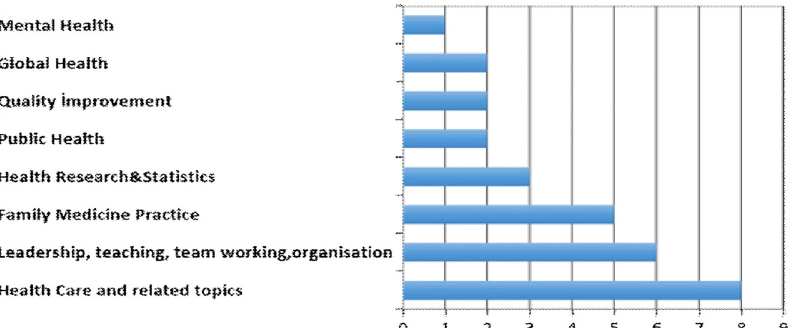
Figure 2: Desires of the participants on possible future